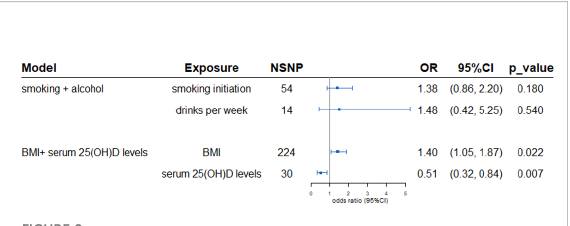
FIGURE 2 Multivariable Mendelian randomization estimated the association between exposures and outcome PBC adjusts of confounding. In the smoking and drinks model, for alcohol, OR is per 1 SD increase in log-transformed weekly alcohol drinks consumed (multivariable MR adjusts for smoking). For smoking, OR is per 1 SD increase in the log odds of smoking initiation (multivariable MR adjusts for alcohol consumption). Similar in BMI and serum 25(OH)D levels model. SNPs, Single nucleotide polymorphisms; OR, Odds ratio; CI, Con fi dence interval; BMI, body mass